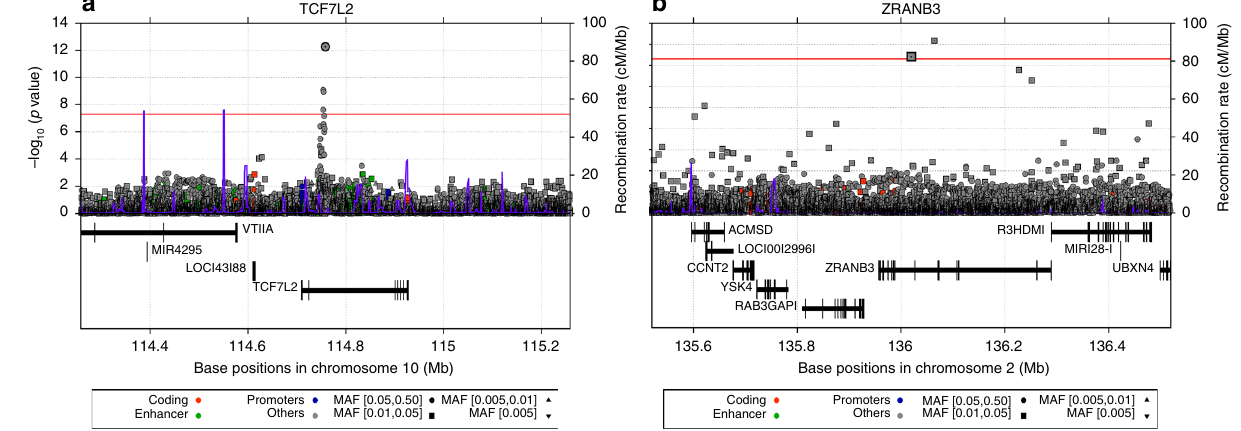
Fig. 2 Regional association plots for TCF7L2 and ZRANB3 in the AADM GWAS for